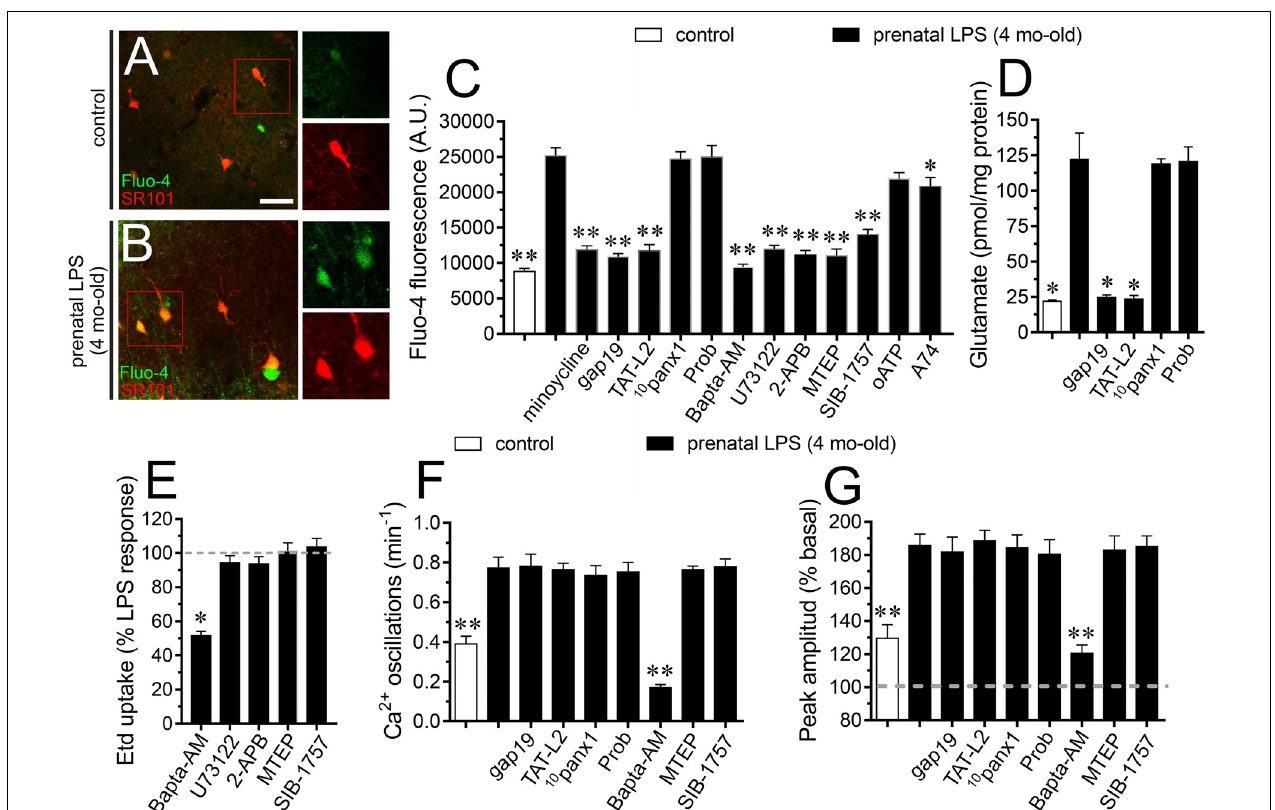
FIGURE 4 | Prenatal LPS-induced opening of Cx43 hemichannels increases [Ca 2 + ] i and glutamatergic signaling on offspring hippocampus. Representative images showing SR101 (red) and Fluo-3 (green) staining by hippocampal astrocytes in acute slices from control offspring (A) or prenatally LPS-exposed offspring (B) of 4 months old. Insets of astrocytes were taken from the area depicted within the red squares in (A,B). (C) Averaged of basal Fluo-4 signal fluorescence by hippocampal astrocytes in acute slices from control offspring (white bar) or prenatally LPS-exposed offspring of 4 months old alone (black bars) or in combination with the following pharmacological agents: 50 nM minocycline, 100 µ M gap19, 100 µ M Tat-L2, 100 µ M 10 panx1, 500 µ M Probenecid (Prob), 10 µ M Bapta-AM, 5 µ M U-73122, 50 µ M 2-APB, 50 nM MTEP, 5 µ M SIB-1757, 200 µ M oATP and 200 nM A740003. ∗∗ p < 0.0001, ∗ p < 0.005 versus LPS, one-way ANOVA Tukey’s post hoc test, mean ± S.E.M., n = 3. (D) Averaged data of glutamate release by acute hippocampal slices from control offspring (white bar) or prenatally LPS-exposed offspring of 4 months old alone (black bars) or in combination with the following blockers: 100 µ M gap19, 100 µ M Tat-L2, 100 µ M 10 panx1, 500 µ M Probenecid (Prob). ∗ p < 0.0001 versus LPS, one-way ANOVA Tukey’s post hoc test, mean ± S.E.M., n = 3. (E) Averaged data normalized to the maximal effect (dashed line) induced by prenatal LPS exposure on Etd uptake by hippocampal astrocytes in acute slices from 4 months old offspring exposed to the following